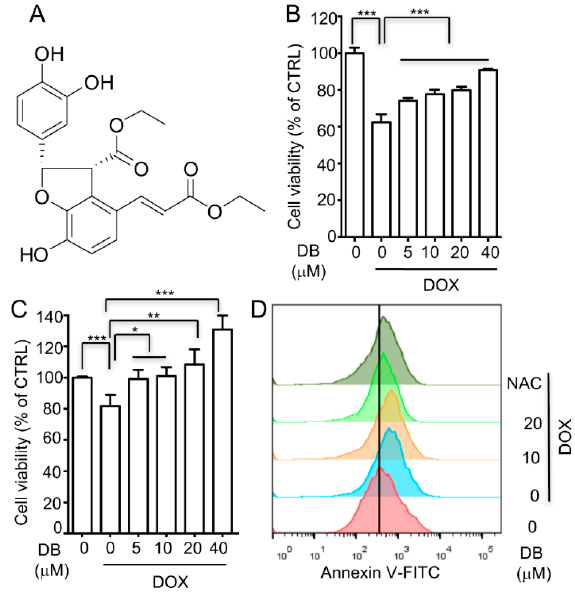
Figure 1. Diethyl blechnic (DB) protects cells from doxorubicin (DOX)-induced cell death. ( A ) The Diethyl blechnic (DB) protects cells from doxorubicin (DOX)-induced cell chemical structure of DB; ( B , C ) DB inhibits DOX-induced viability loss ( n = 6). ( B ) H9c2 cells ( C ) primary cardiomyocytes were treated with DOX (1 μ M) for 24 h with and without DB pre-treatment, and the surviving cells were analyzed using MTT assay; ( D ) Effect of DB on the apoptotic index in H9c2 cells after DOX insult. Apoptotic cell death was detected with Annexin V staining by using flow cytometry. Data represent the mean ± SD ( n = 3) and were analyzed by ANOVA. * p < 0.05, ** p < 0.01, *** p < 0.001 for each group versus DOX without DB.